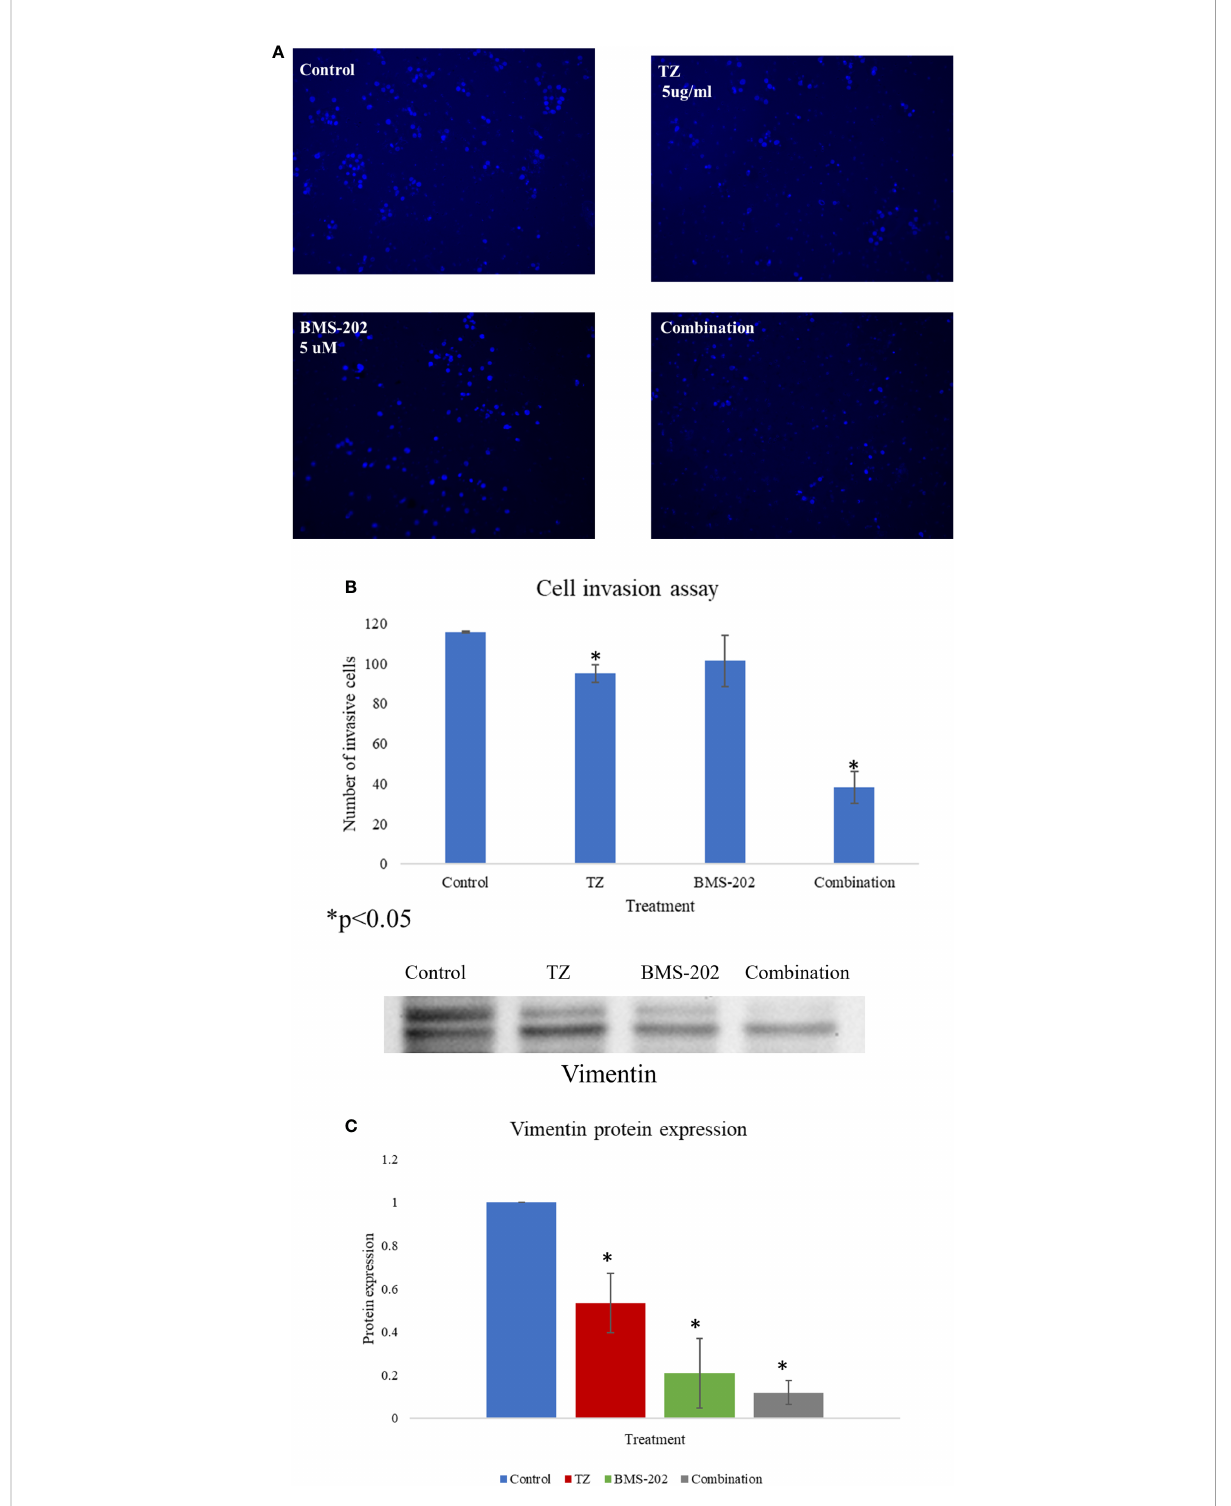
FIGURE 3 (A – C) . (A) The impact of TZ, BMS-202, and a combination of both on ZR75 cell invasiveness. (A) Compared to the control, both TZ and the combination therapy inhibit ZR75 cell invasion, with a more pronounced effect upon treatment with the combination therapy. (B) The number of invasive cells was quanti fi ed using ImageJ. (C) The changes in vimentin expression after treatment with TZ, BMS-202, and their combination. Data are presented as a percentage of the viable cells ±